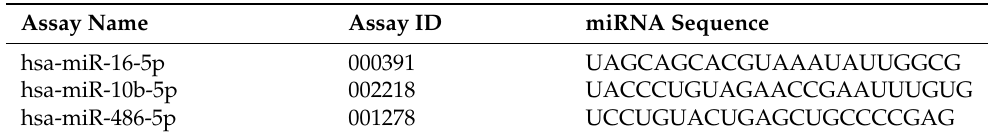
Table 1. miRNA primers used in the